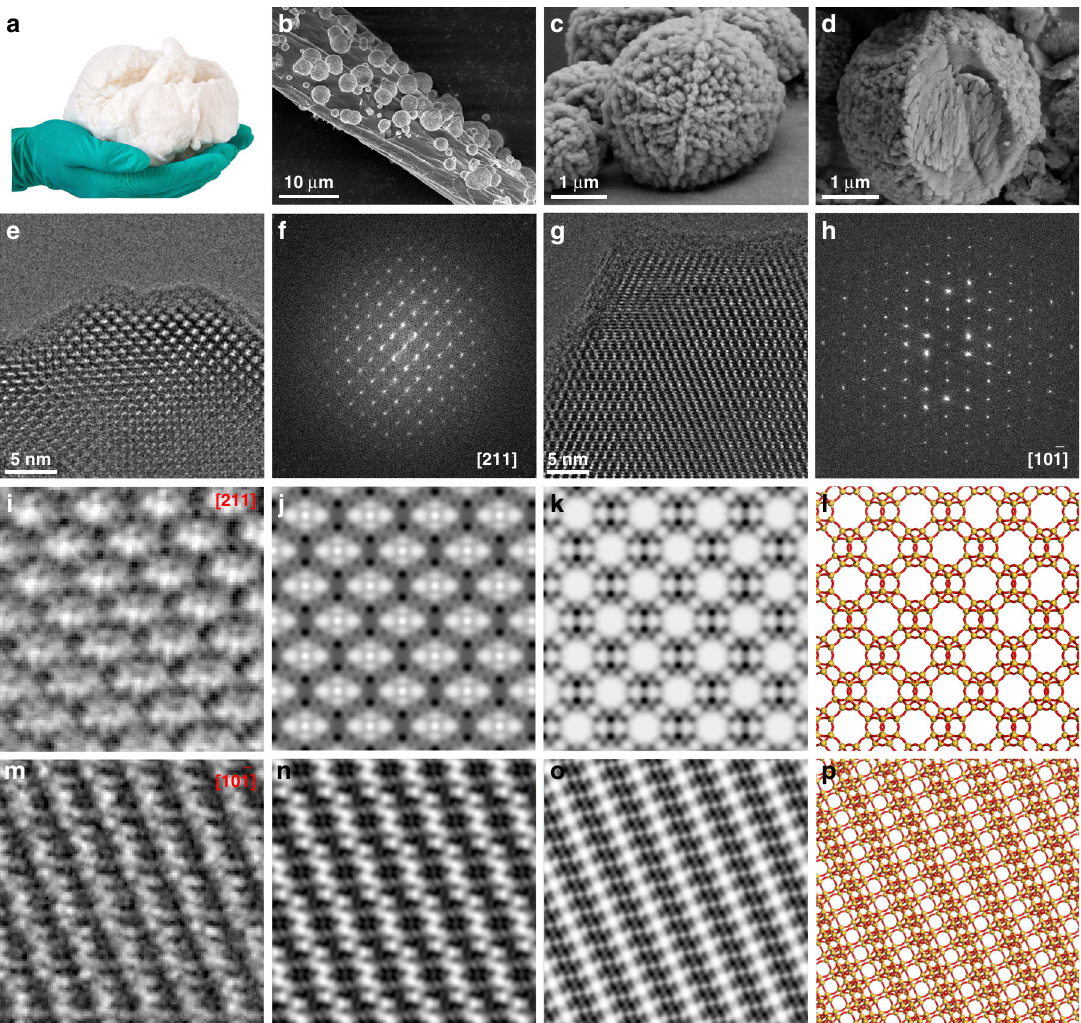
Fig. 1 Characterization of mCHA-C. a Photograph of mCHA-C. FE-SEM images of ( b ) mCHA-C, ( c ) mCHA zeolite on cotton, and ( d ) mCHA zeolite after removing cotton fi ber by calcination. HRTEM images and corresponding FFT of individual CHA crystals taken along the ( e , f ) [211] and ( g , h ) [10 (cid:1) 1] zone axes, respectively. i , m CTF-corrected and denoised images using a Wiener fi lter at a defocus value of − 630 nm and − 22 nm, respectively, ( j , n ) Cmm and P2 projection symmetry-imposed and lattice-averaged images, where the averaged in-channel contrast in ( j ) might originate from either adsorbate species or CTF effects ( k , o ) simulated projected potential maps with a point spread function width of 1.4 Å, ( l , p ) projected structural models of the CHA along [211] and [10 (cid:1) 1] zone axes,